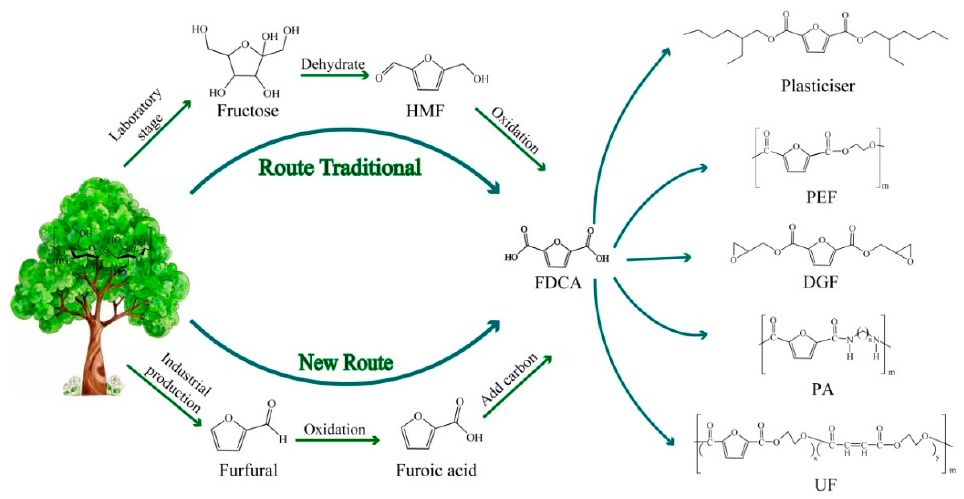
Figure 1. Synthetic pathway of FDCA and its derivatives from biomass.